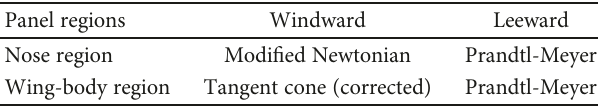
Table 3: Selected impact methods for aerodynamic